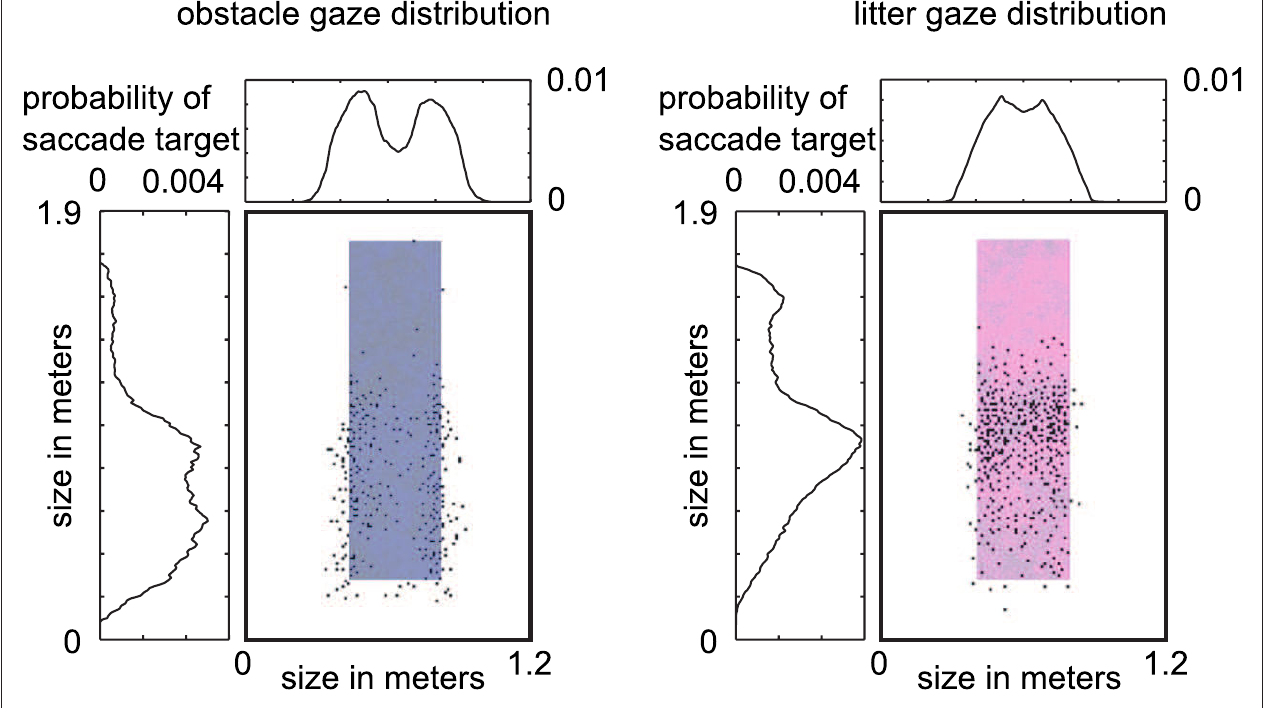
Figure 2 | Human gaze data for the same environment showing striking evidence for visual routines. Humans in the same environment as the avatar precisely manipulate gaze location depending on the specific task goal. The small black dots show the location of all fixation points on litter and obstacles. When avoiding obstacles (left) gaze points cluster at the edges of the object. When picking up a similar object (right) gaze points cluster on the center. From Rothkopf and Ballard (2009).